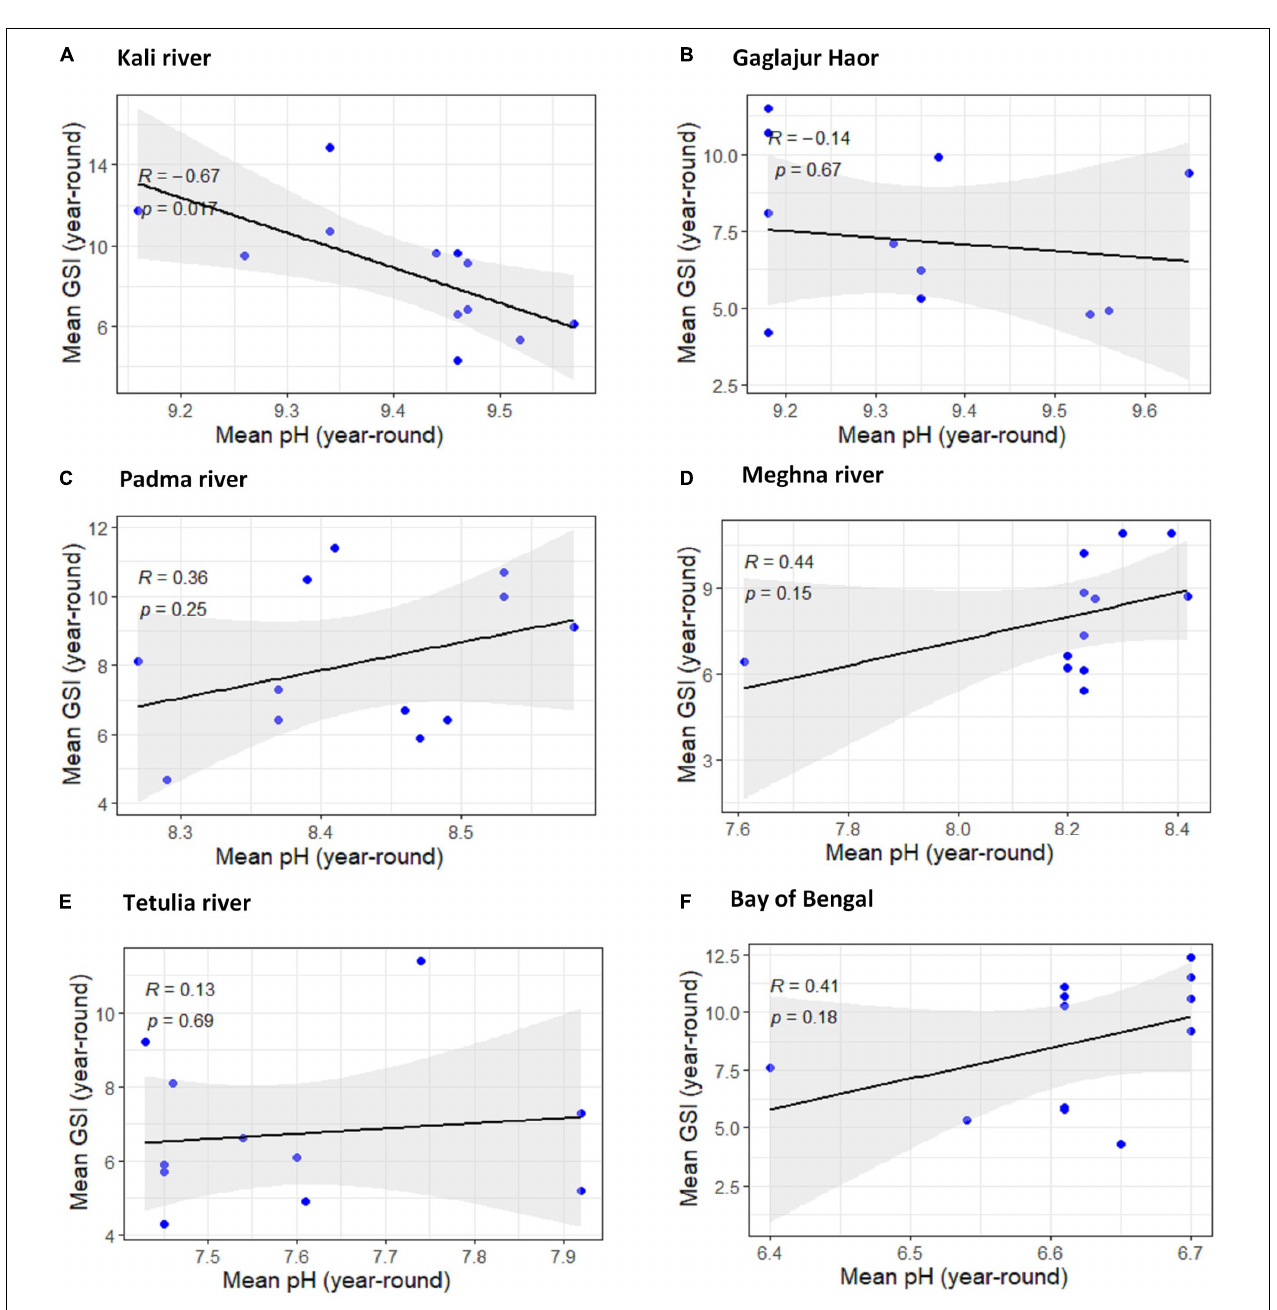
FIGURE 7 | Scatter plot and linear regression for the year-round means of Gonadosomatic index (GSI) of Tenualosa ilisha against mean pH for six diverse habitats across Bangladesh: (A) Kali river, (B) Gaglajur Haor, (C) Padma river, (D) Meghna river, (E) Tetulia river, and (F) Bay of Bengal. Pearson correlation coefficient is reported as “R” while probability value is reported as